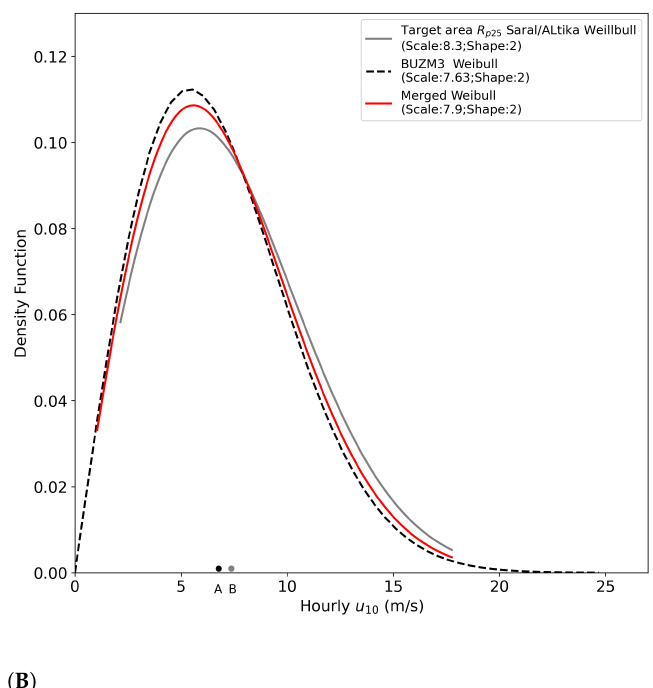
Figure 10. ( A ) The scatter plot and the marginal histograms with fitted Weibull distributions of the u 10 from target area R p 25 SARAL/AltiKa and BUZM3 station. A and k are Weibull parameters of scale and shape. ( B ) The Weibull distribution (red line) showing the wind characteristics in the target area estimated from target area R p 25 SARAL/AltiKa (gray line) and BUZM3 station (dashed black line). Points A and B are mean u 10 ( u 10 ) from observations of BUZM3 station and target area R p 25 SARAL/AltiKa, respectively.